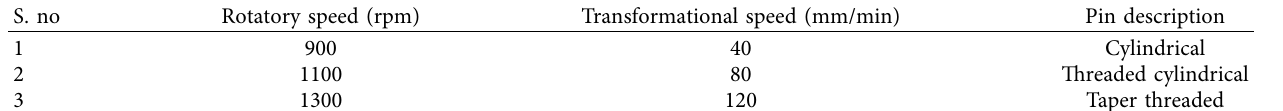
Table 3: Friction stir-welding criteria.